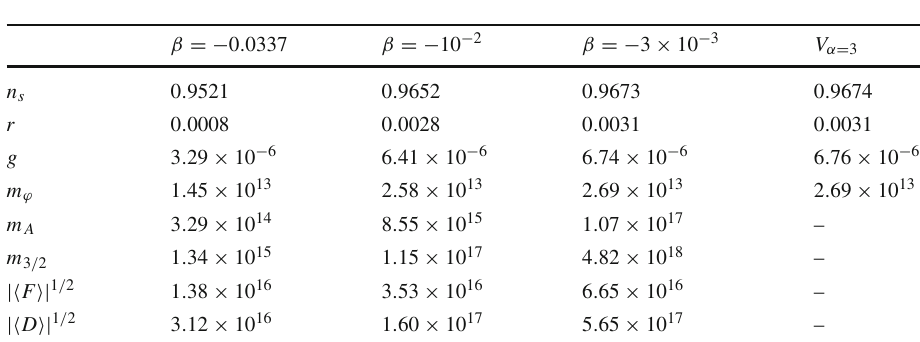
observables n s and r ; the inflaton, vector, gravitino masses ( m ϕ , m A , m 3 / 2 , respectively), and SUSY breaking parameters for our model with α = 3 and positive β . The observables and the inflaton mass for the α -attractor potential (46) are included. The parameters m ϕ , m A , m 3 / 2 ,